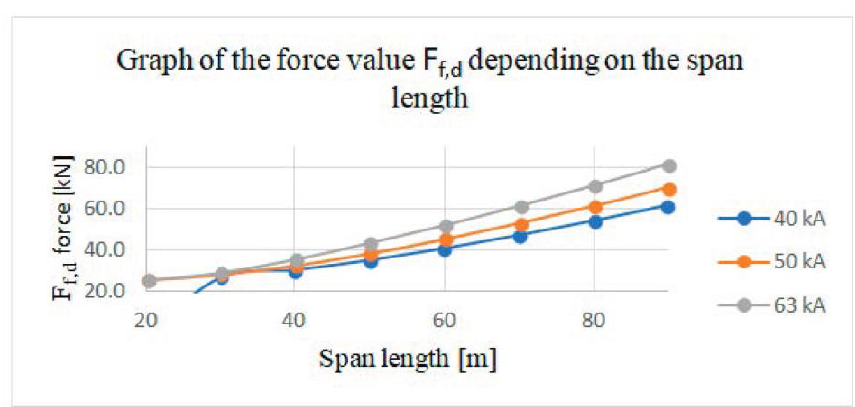
Figure 6. Graph of the value of the force F t,d depending on the span length.